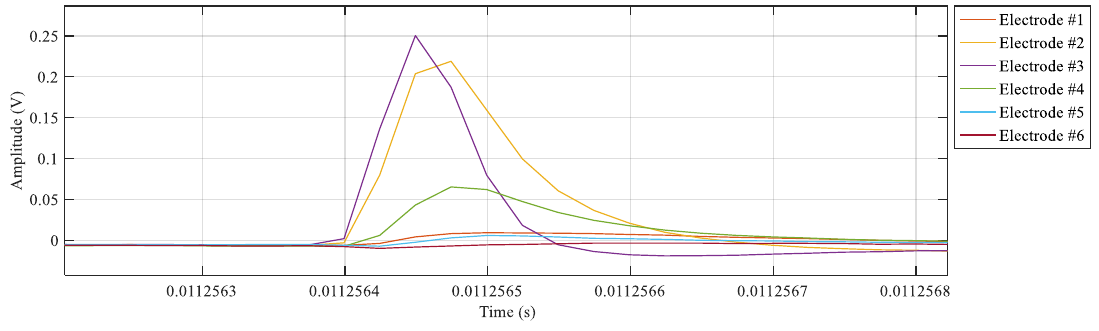
Figure 13. Measured voltage at the electrodes during a PD (at nominal voltage).